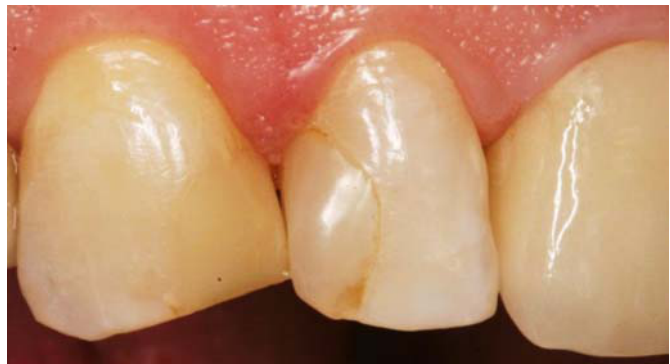
Figure 16. A clinical situation. It is unclear and difficult to determine visually whether the discolored margin of the composite restoration results from an interfacial margin gap.